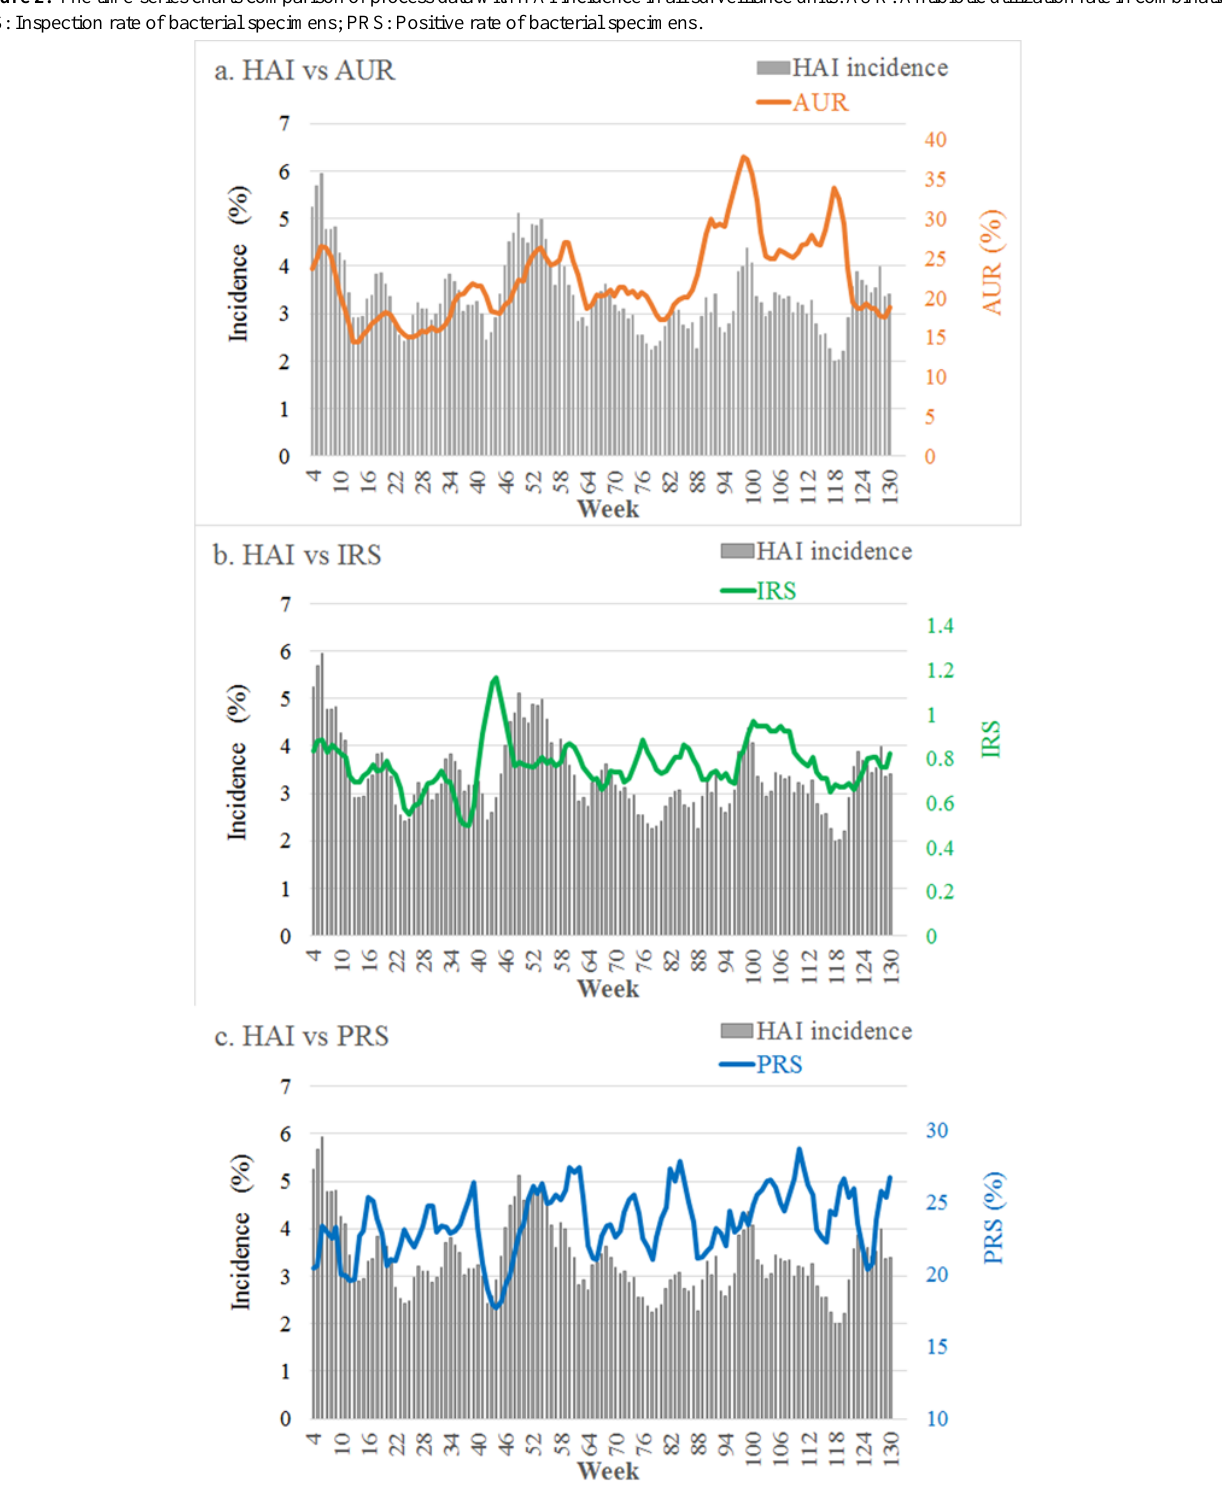
Figure 2. The time-series charts comparison of process data with HAI incidence in all surveillance units. AUR: Antibiotic utilization rate in combination; IRS: Inspection rate of bacterial specimens; PRS: Positive rate of bacterial